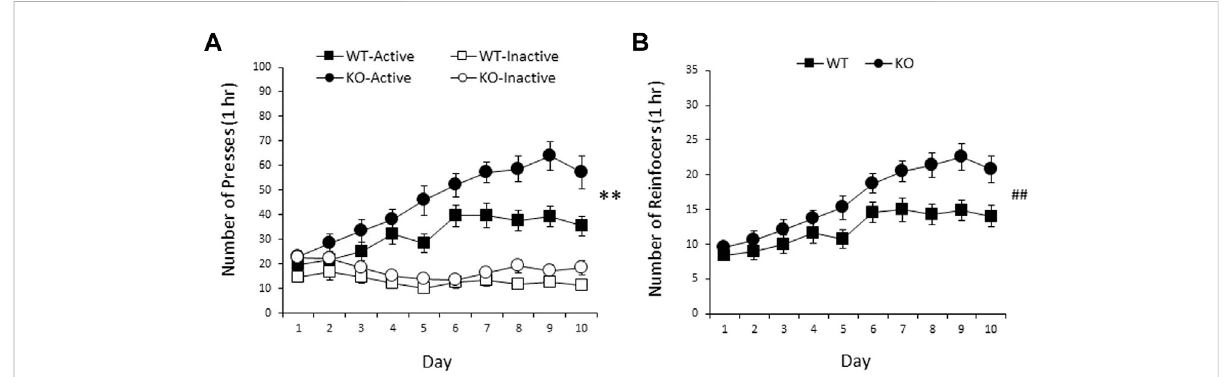
FIGURE 4 Nicotine SA in male and female RasGRF2 KO mice and WT controls. (A) RasGRF2 KO mice demonstrated an increase in responding on the nicotine-associated lever relative to WT controls ( n = 23/group). Data represent mean number of presses (±SEM) on the active and inactive levers during 10 daily 1 h sessions of nicotine SA (0.03 mg/kg/35 µl infusion). (B) RasGRF2 KO mice demonstrated an increase in the number of nicotine reinforcers achieved relative to WT controls. Data represent mean number of nicotine reinforcers (±SEM) achieved during 10 daily 1 h sessions of nicotine SA (0.03 mg/kg/35 µl infusion). ** p < 0.005; ## p < 0.005, main effect of